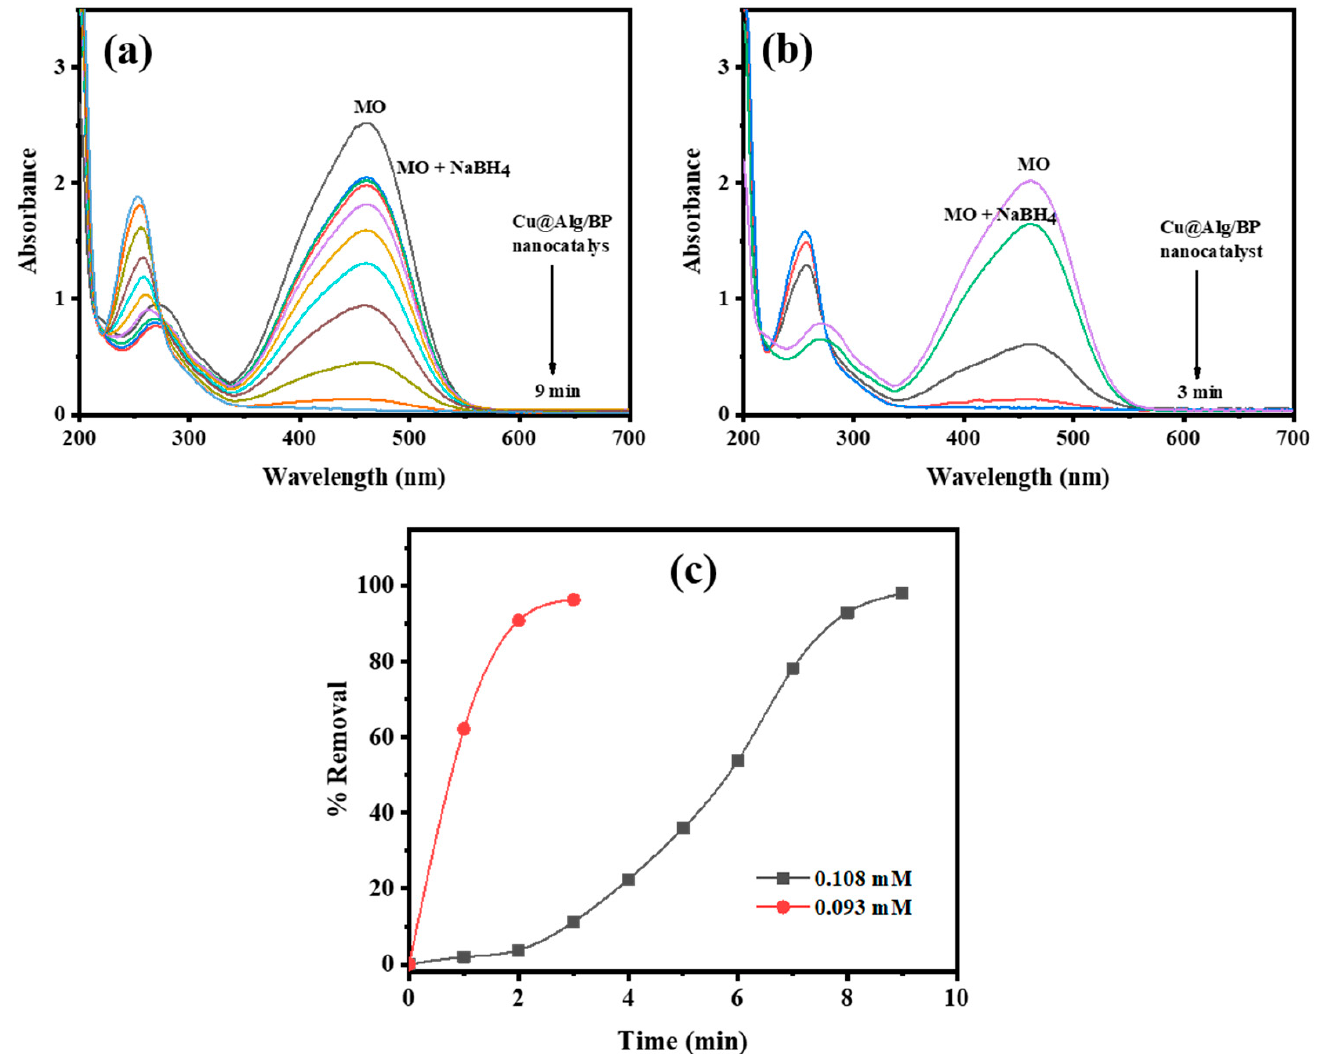
Figure 7. Time-dependent UV–vis spectra for MO reduction ( a ) 0.108 mM; ( b ) 0.093 mM by NaBH 4 using 3 beads of Cu@Alg/BP nanocatalyst. ( c ) Removal % of MO in presence of Cu@Alg/BP. Effect of NaBH Concentration on MO Reduction 4